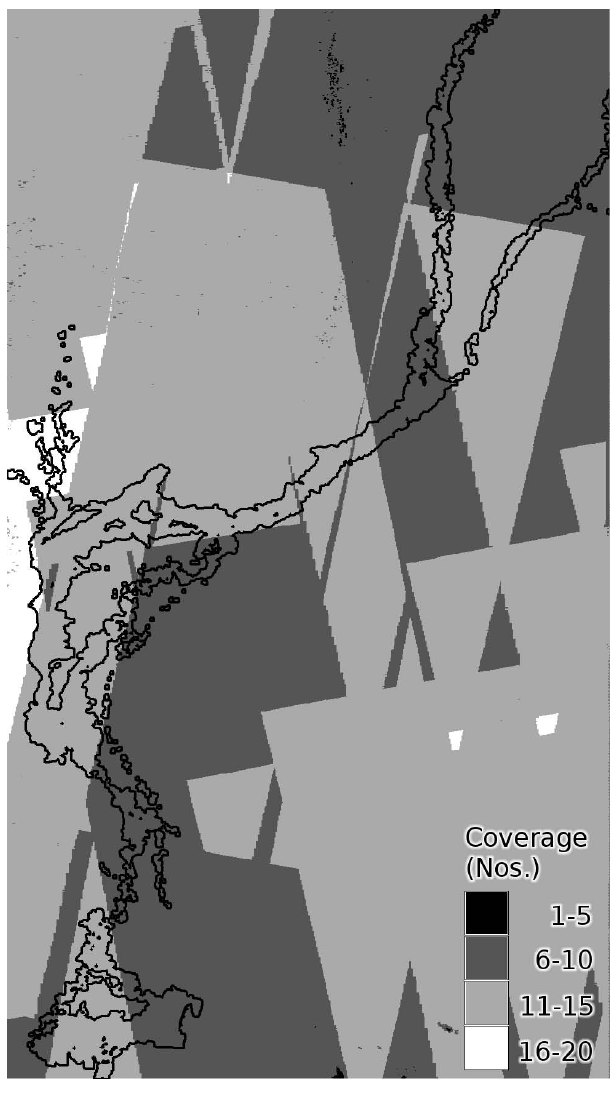
Fig. 5. Count of frequency of cover by GM data over the 98 day study period. The black outlines represents the maximum flood